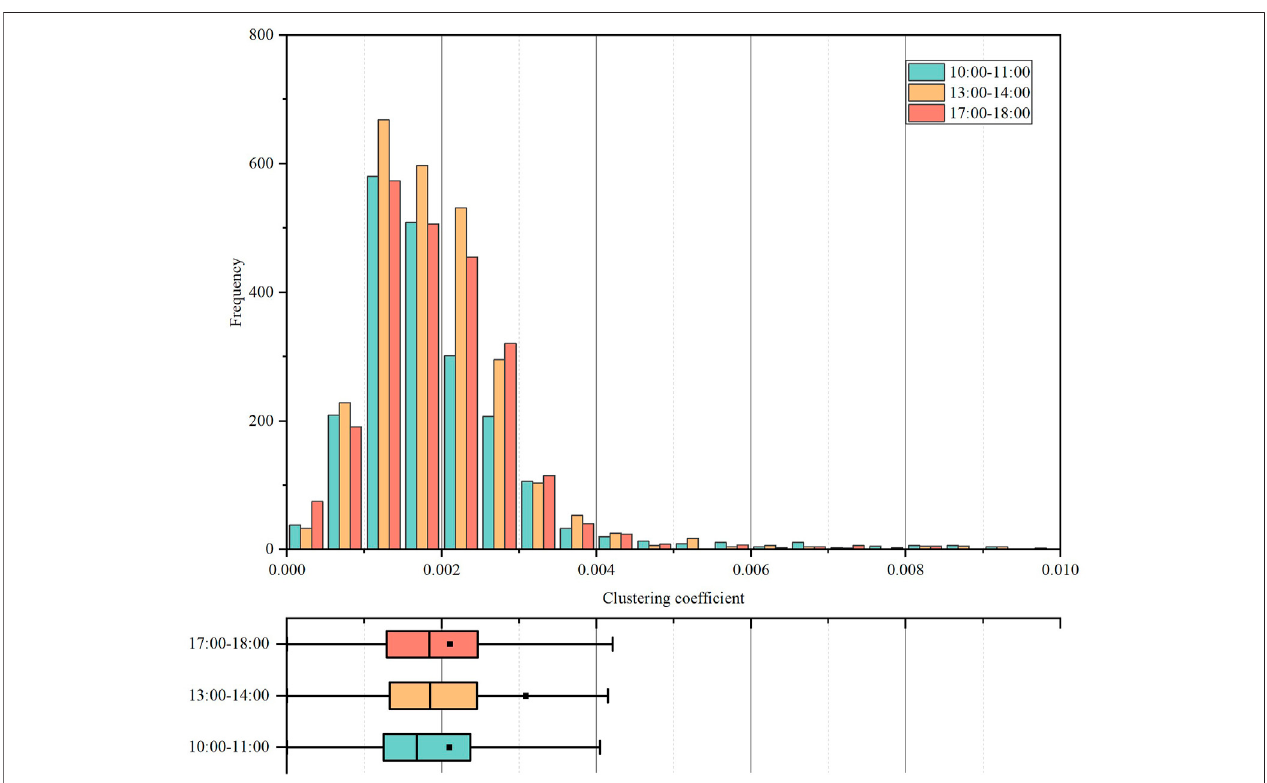
FIGURE 10 | Frequency distributions of clustering coef fi cients in the weighted contact network.